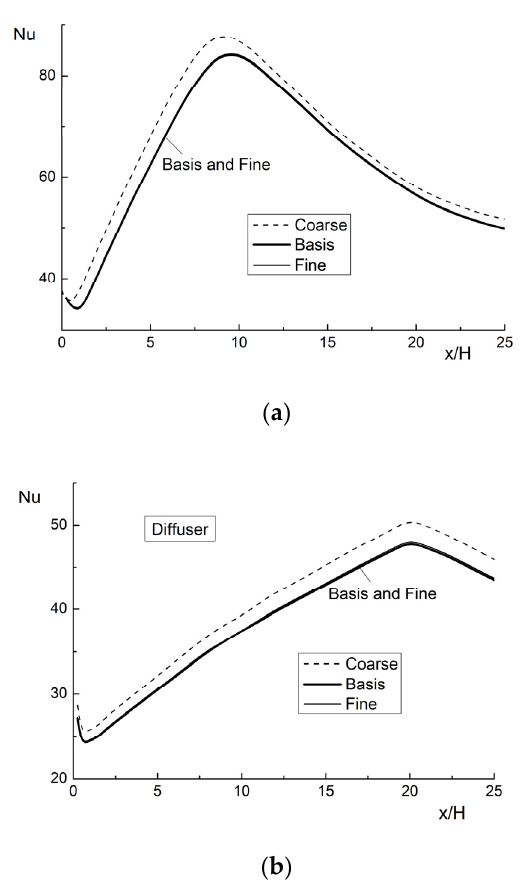
Figure 2. Grid independence tests for confuser at φ = − 1° ( a ) and diffuser at φ = 5° ( b ).